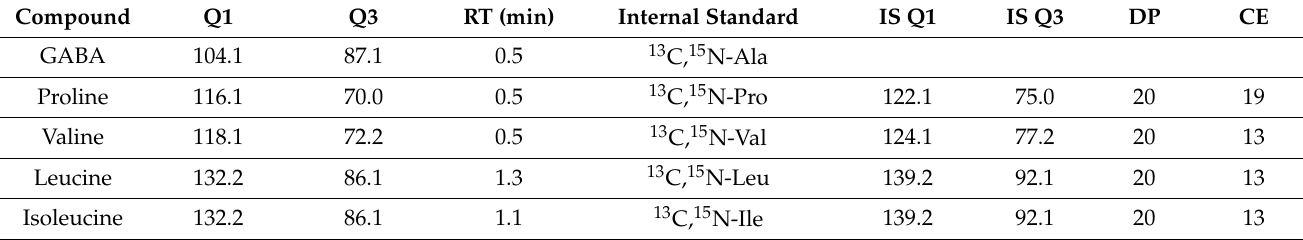
Table 1. Details on the analysis of GABA and amino acids proline, valine, leucine and isoleucine